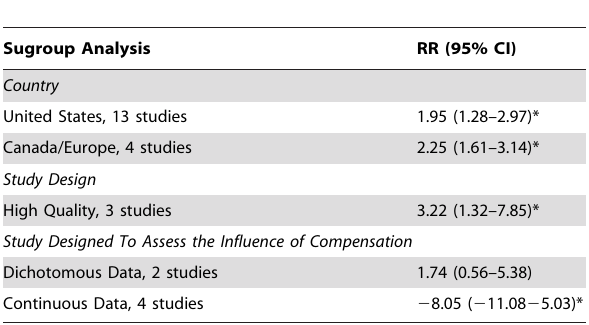
Table 4. Additional Subgroup